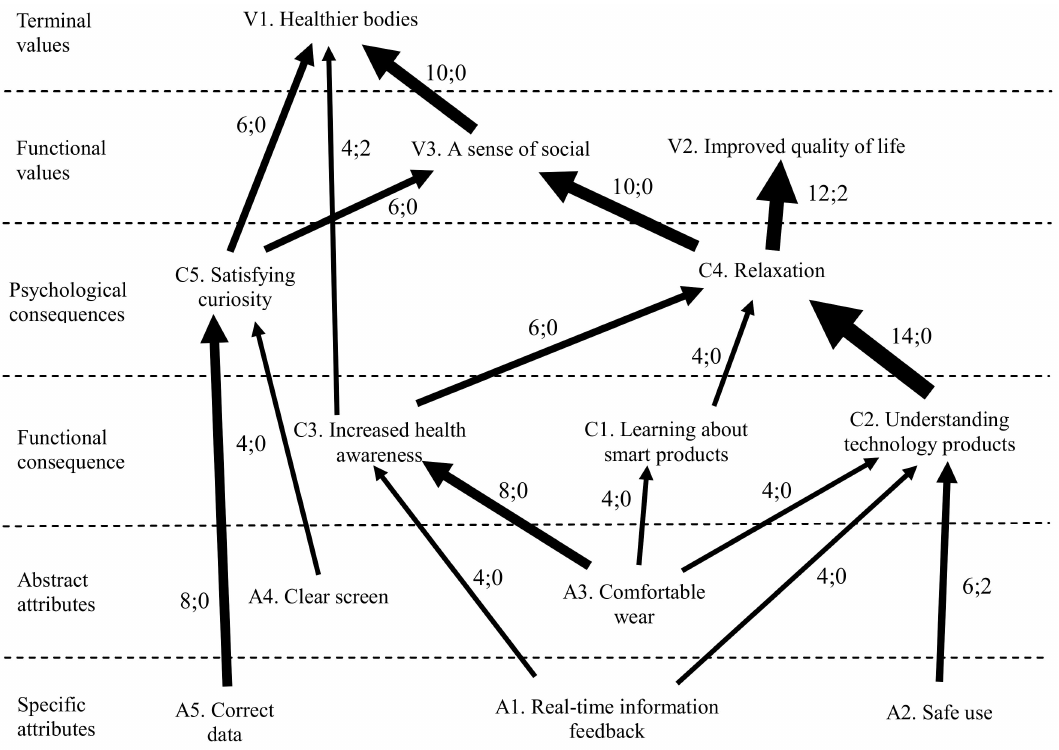
Figure 1. Hierarchical value map for mobile health